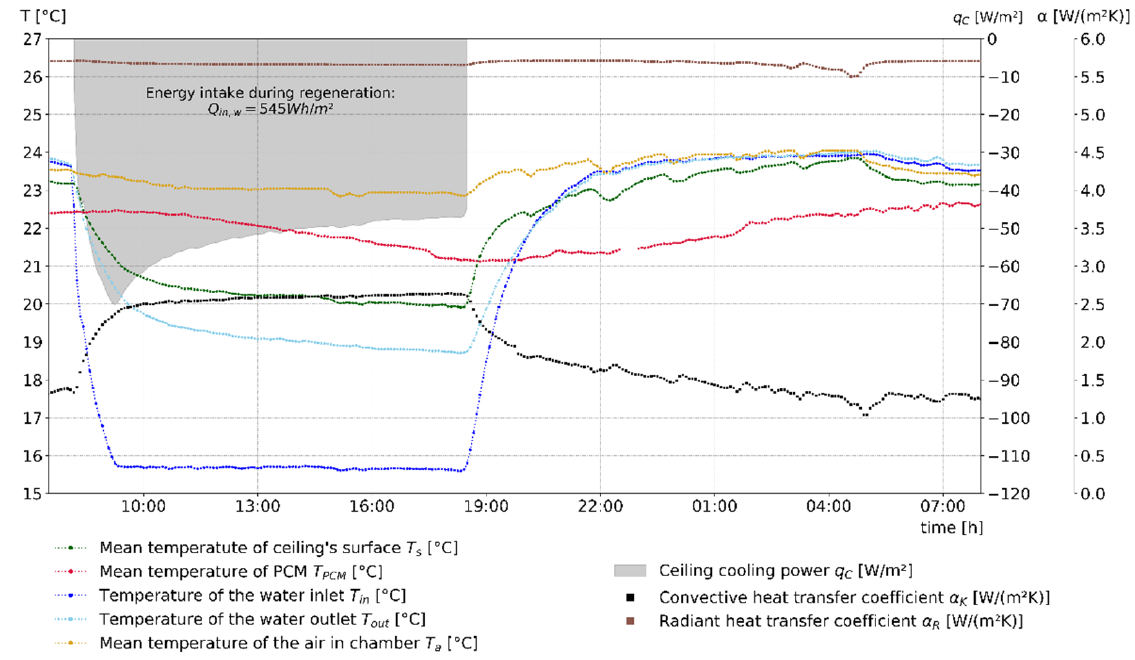
Figure 9. Experimental results for variant IIb.